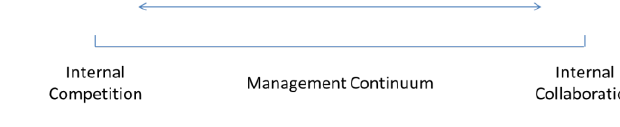
Figure 1: The management continuum model Combinations of internal competition and